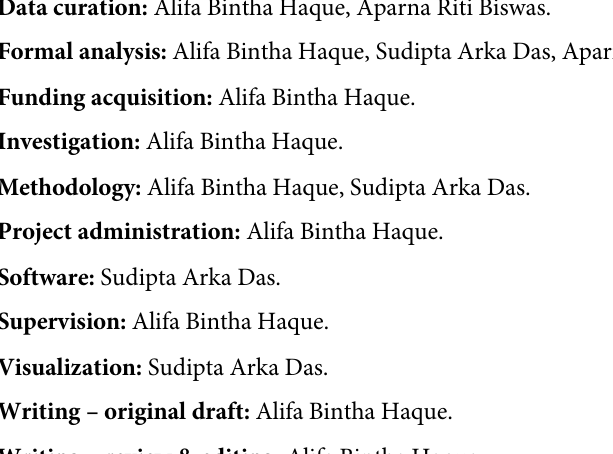
S1 Fig. Molecular species identification using the mitochondrial COI gene for individual samples (n = 34). Neighbour-joining tree of COI gene of supplied specimens and related sequences downloaded from NCBI GenBank are shown individually for each sample. Boot- strap values are shown on each branch. S2 Fig. Maximum likelihood tree based on COI sequences from related samples in ‘boldsystems.org‘ public data portal. Glaucostegus typus (accession number: MH841985) and Mobula mobular (accession number: MH842002) shows discrepancies with NCBI BLAST based molecular species identification (See supporting information S2 Fig). S1 Table. Pairwise distance table. S2 Table. Comparative results on identification of specimens using two different databases with their accession